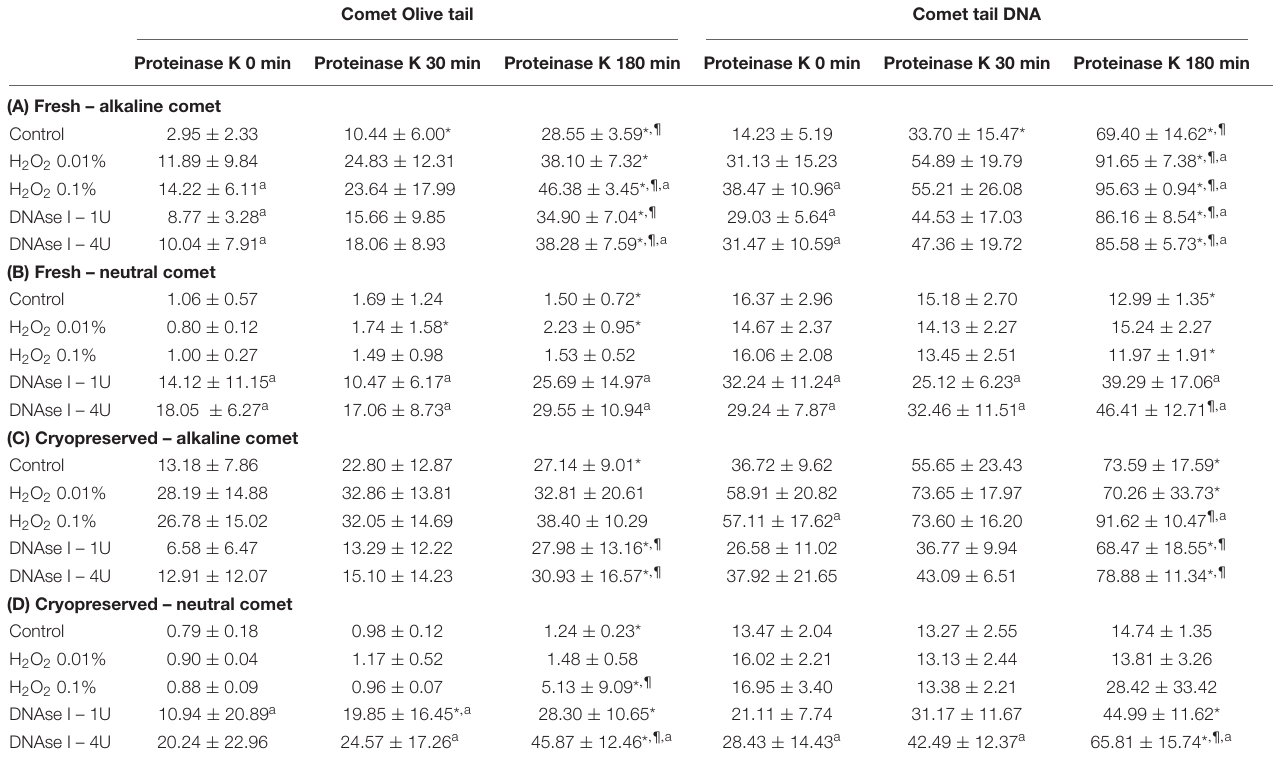
TABLE 1 | Olive tail moment and tail DNA parameters showing the amount of sperm DNA breaks detected in sperm cells after different H 2 O 2 and DNAse I treatments in different proteinase K conditions. Comet Olive tail Comet tail